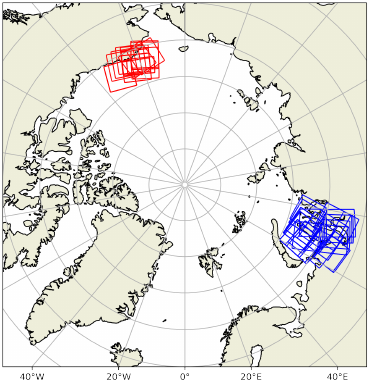
Figure 1. Sentinel-1 images collected over the two test sites: in red—Alaska test site; in blue—Yamal test